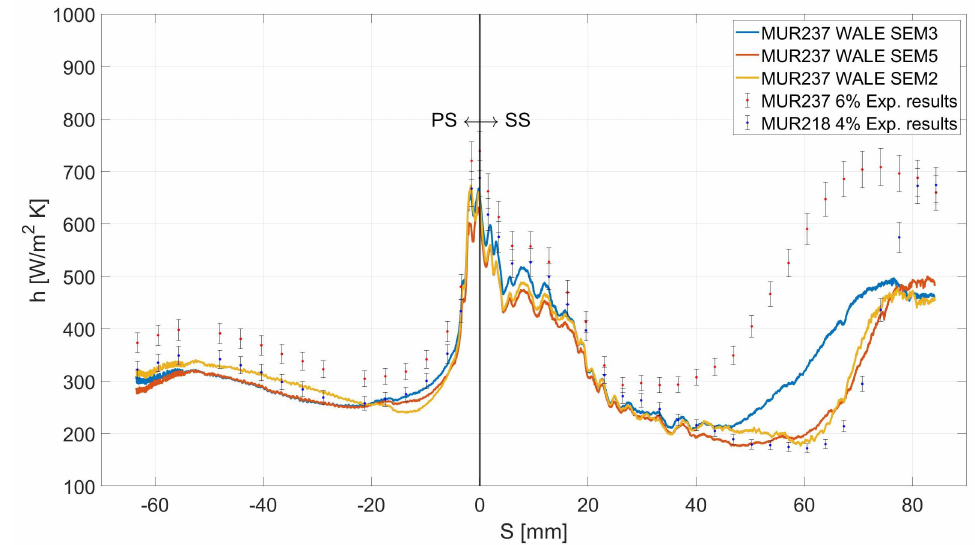
Figure 5. Influence of the turbulence length scales: convective heat transfer coefficient.